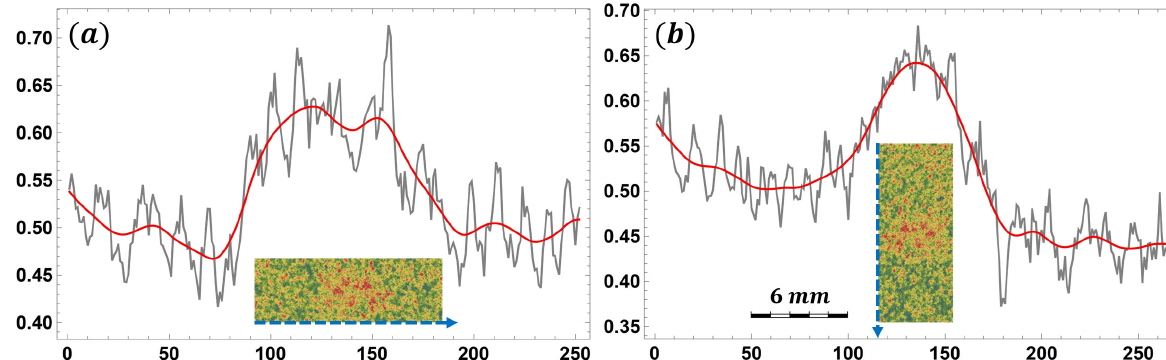
Figure 2. Bubble neighborhood analysis: width mean of luminance (gray) over the length of ( a ) horizontal and ( b ) vertical patches roughly fitted to the bubble region within the FOV. Normalized luminance versus pixel coordinates is shown in both cases. Note the pixel-to- mm scale bar in ( b ). Bubble neighborhood patches shown in ( a , b ) are not to scale and are normalized as in Figure 1. Scan directions are indicated by the dashed blue arrows and the red curve is the total variation filtered (Gaussian, regularization parameter equal to 1 [58]) gray